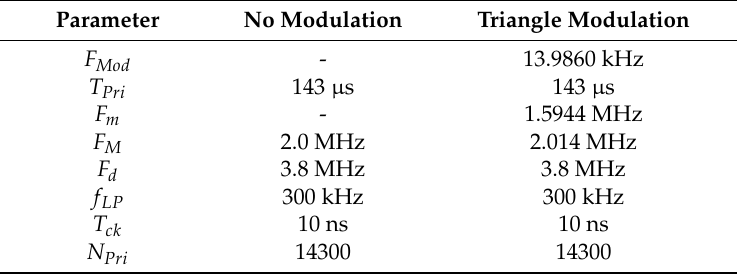
Table 3. Parameters used in simulations where the conditions for noise suppression were met.